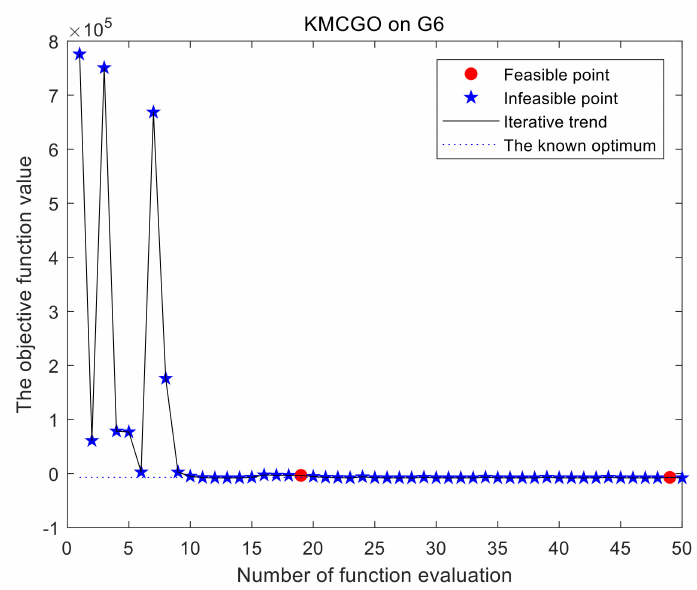
Figure 5. Iteration result of the G6